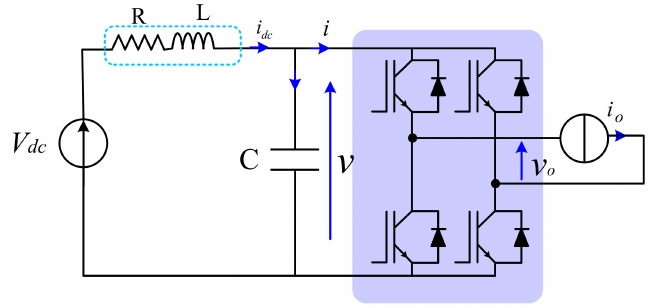
Figure 1. Basic circuit scheme of the single-phase full-bridge (H-bridge) inverter to determine the DC-link voltage